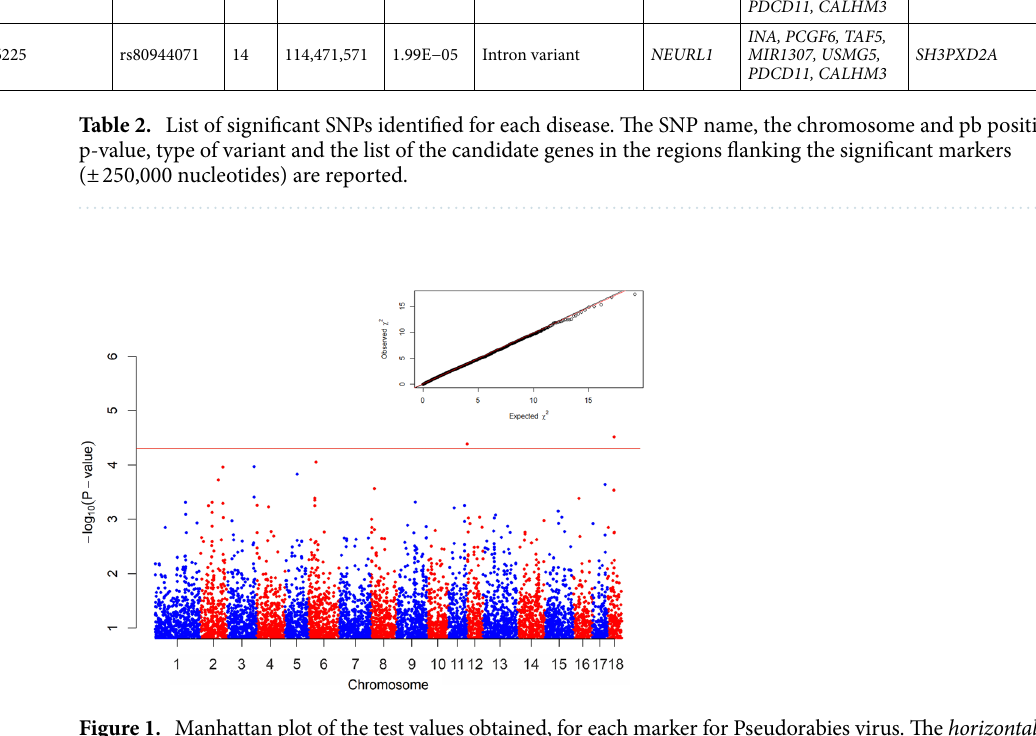
Figure 1. Manhattan plot of the test values obtained, for each marker for Pseudorabies virus. The horizontal red line separated the two most significant markers (P <